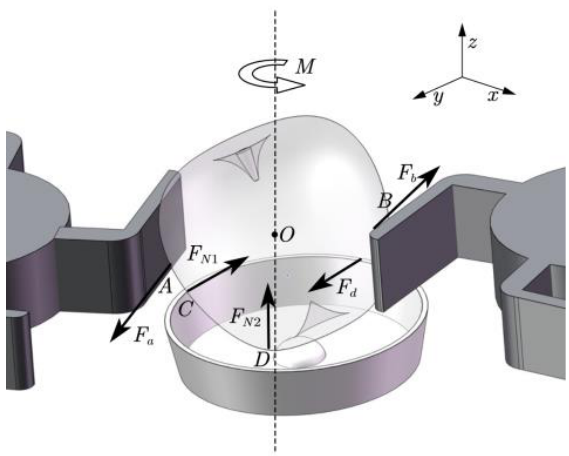
Figure 7. Apple vertical posture adjustment mechanics sketch.